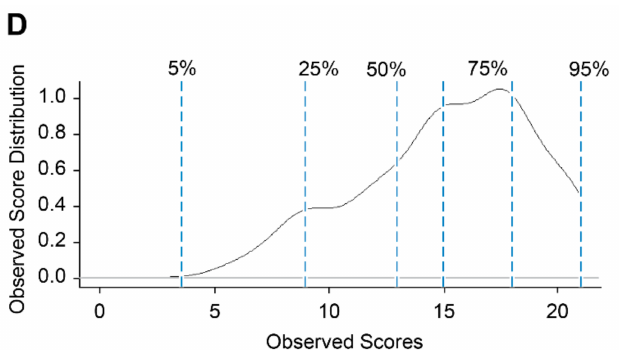
Figure 1. Item option characteristic curves and kernel distribution of the UWES-3 total score.